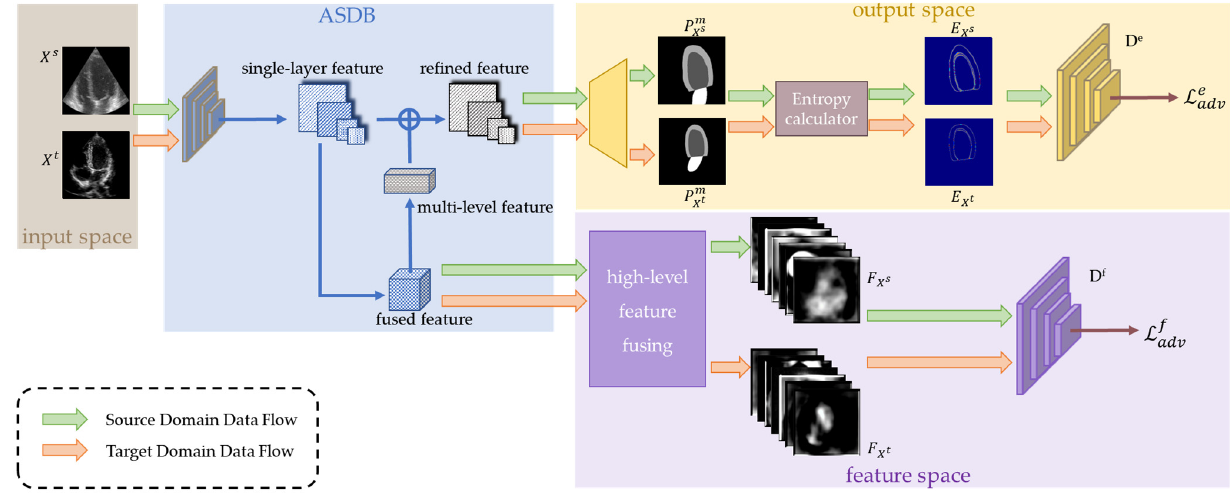
Figure 2. Overview of the proposed MACS. The MACS consists of an attention-based dual-branch segmentation module (ASDB), a discriminator in feature space, and a discriminator in the output space. Source domain images ( 𝑋 (cid:3020) ) and target domain images ( 𝑋 (cid:3021) ) are segmented by the ASDB which is optimized using only source domain samples. The output of the segmentation network contains predicted masks ( 𝑃 (cid:3025)(cid:3040) ) and high-level intermediate features ( 𝐹 (cid:3025) ). The entropy map (𝐸 (cid:3025) ) is calculated from the segmentation prediction 𝑃 (cid:3025)(cid:3040) . 𝑃 (cid:3025)(cid:3040) and 𝐸 (cid:3025) from two different domains are forced to be aligned by discriminators, making the ASDB output accurate segmentation on unseen target domain dataset.